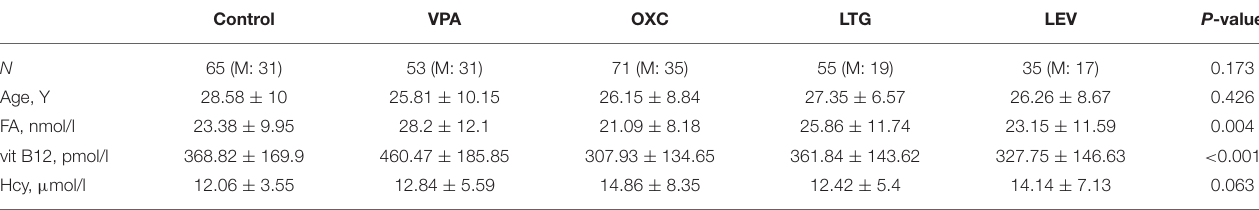
TABLE 1 | Demographic features of the subjects.